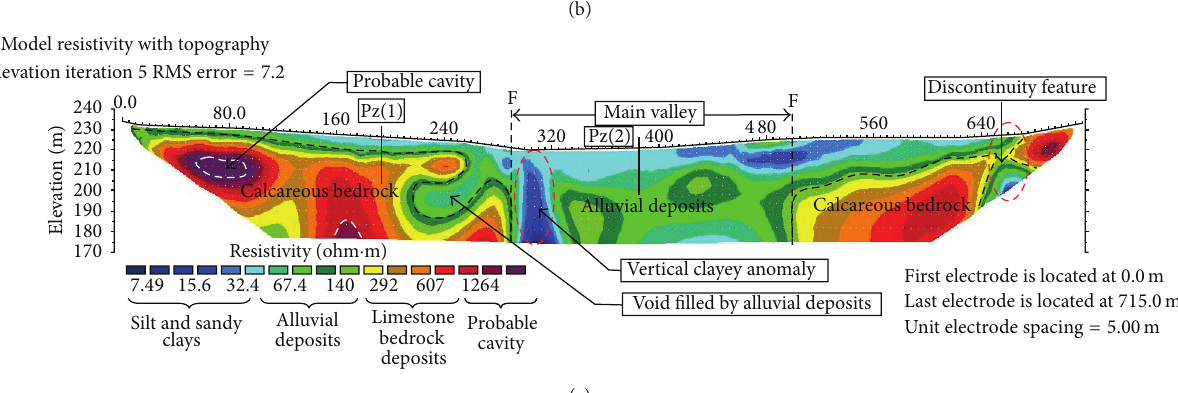
Table 1: Resistivities values of the detected subsurface features derived from the interpreted ERT sections.